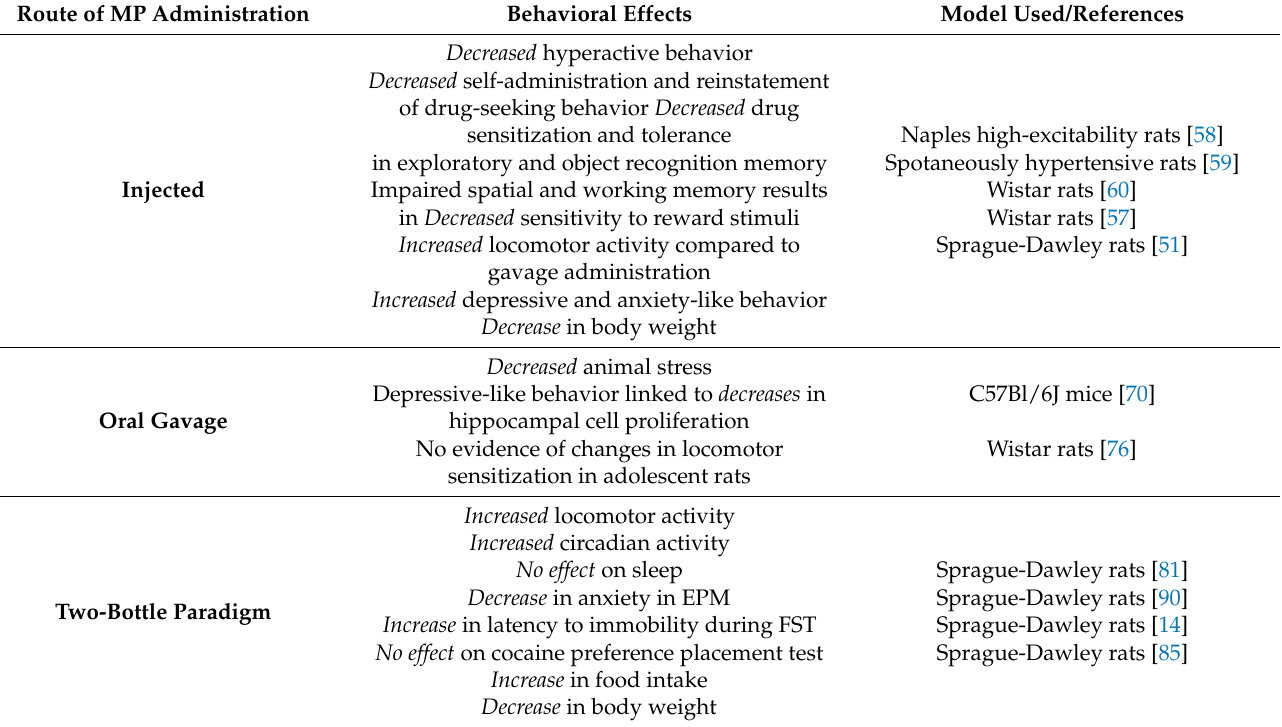
Table 3. Comparison of behavioral effects using injection, oral gavage, and two-bottle paradigm. Route of MP